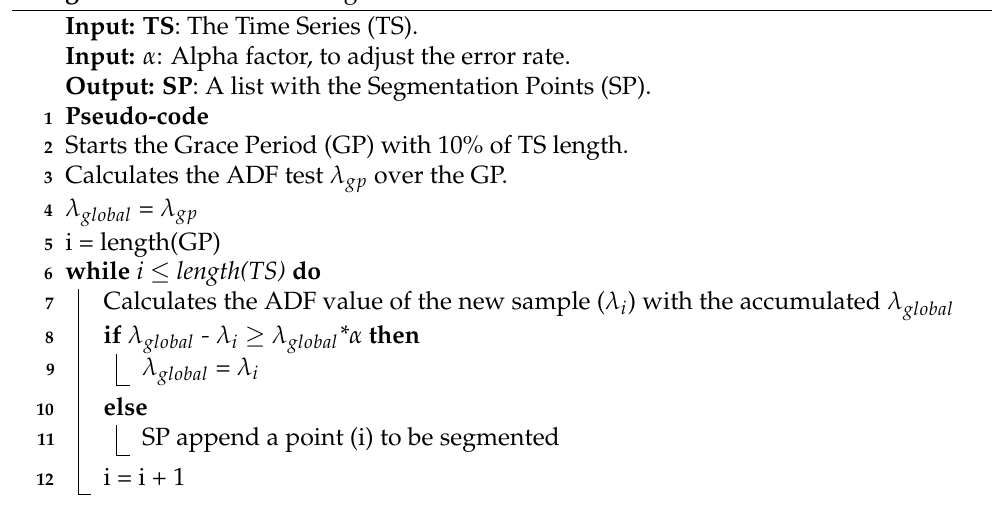
Algorithm 2: ADF-based Segmentation